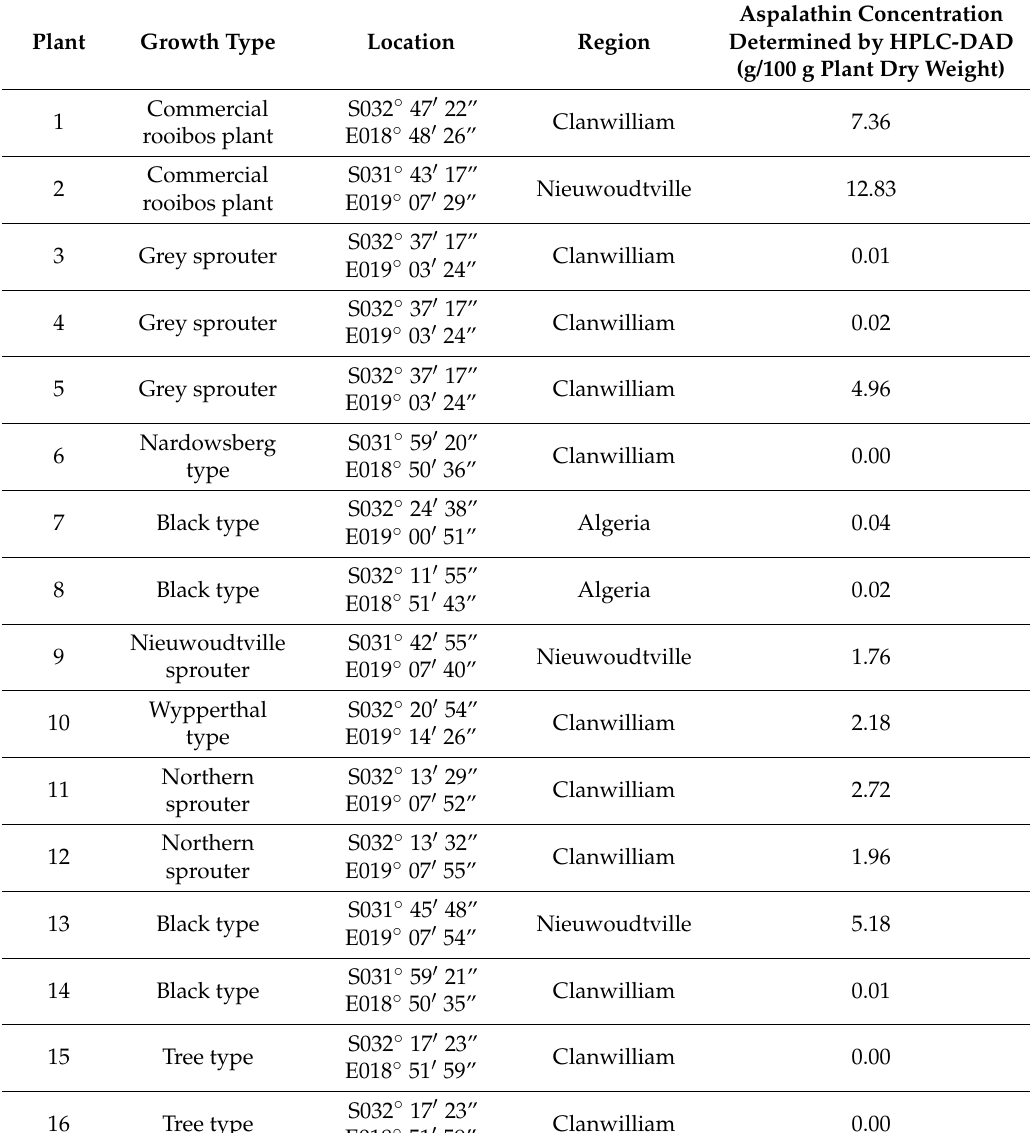
Table 1. Description of rooibos ecotypes used in the